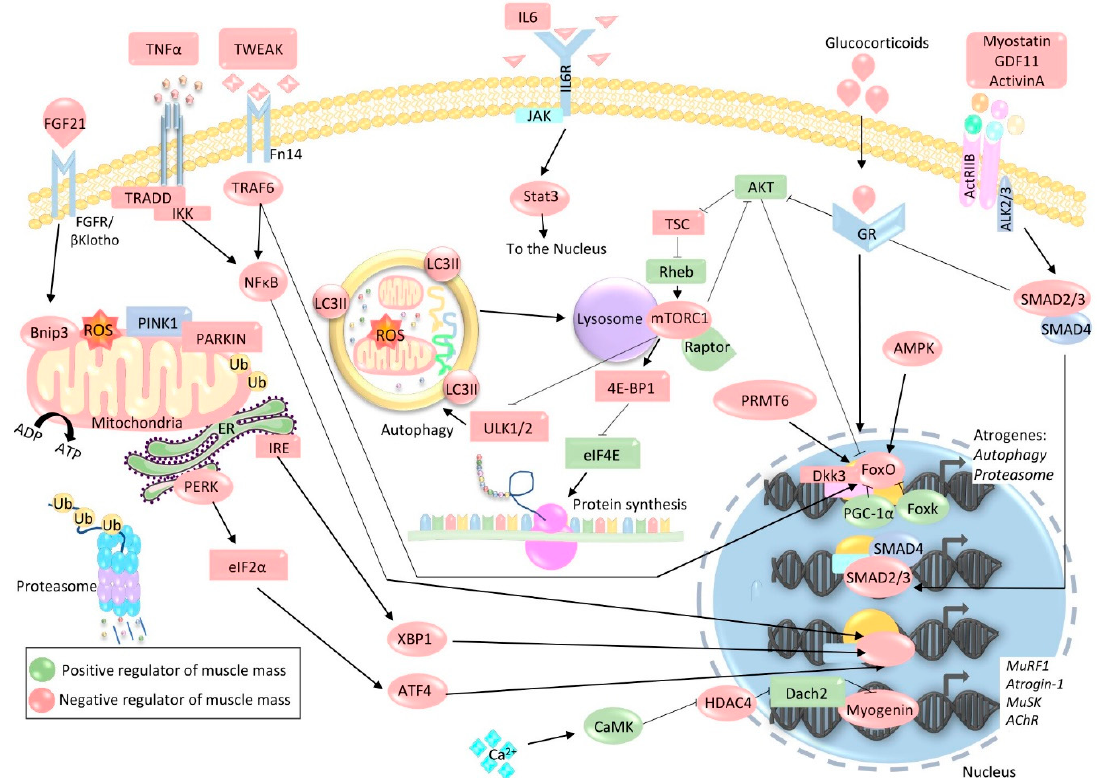
Figure 2. Pathways involved in protein degradation. During muscle atrophy, decreased binding of IGF-1 / insulin to their respective receptors and / or increased binding of glucocorticoids to the glucocorticoid receptor (GR) result in reduced Akt / mTOR activation. This leads to diminished protein synthesis mediated by 4E-BP1-induced inhibition of eIF4E. Diminished mTOR activity also leads to the stimulation of autophagy through ULK1 / 2 signaling. At the same time, reduced Akt activity results in the release of FoxO from its cytosolic captivity, allowing it to activate an atrophic program by stimulating the expression of atrogenes belonging to the autophagy lysosome and ubiquitin proteasome proteolytic pathways. This sustains the increased proteolytic activity of these systems. The FoxO-induced atrophic program can be further enhanced by Dickkopf 3 (Dkk3) and blocked by PGC-1 α and Foxk. Increased binding of activins (ActivinA, growth and di ff erentiation factor 11 (GDF11)) and myostatin to the Activin type 2 (ActRIIB) receptor can contribute to atrophy through the activation of activin receptor-like kinase (ALK)2 / 3 and the formation of the SMAD2 / 3-SMAD4 complex, which in addition to further inhibiting Akt, also induces the expression of proteins involved in atrophy. Muscle atrophy is often accompanied by inflammation, which contributes to proteolysis. Increased levels of circulating cytokines such as tumor necrosis factor α (TNF α ), TNF-like weak inducer of apoptosis (TWEAK), and IL6 leads to the activation of TRAF6, TRADD, IKK, and JAK which, in turn, activate NF- κ B, Stat3, and FoxO, thus enhancing the expression of atrogenes. Mitochondrial dysfunction is also often observed during muscle atrophy, which leads to increased oxidative stress and mitophagy. Oxidative stress stimulates the release of IGF21, which then feeds back onto muscle, enhancing the expression of mitophagy receptor Bnip3. Accumulation of PINK1 and localization of E3 ubiquitin ligase Parkin as well as Bnip3 on the mitochondrial membrane lead to the elimination of dysfunctional mitochondria by mitophagy. Muscle atrophy is also associated with ER stress, which activates the unfolded protein response (UPR). UPR-activated IRE and PERK-eIF2 α then promote atrophic transcriptional programs regulated by X-box binding protein 1 (XBP1) and ATF4, respectively. HDAC4, which is normally supressed by CaMK, is upregulated during denervation, resulting in the inhibition of Dach2, a transcriptional repressor of myogenin. This culminates in increased myogenin-mediated transcription of synaptic factors MuSK and AChR, as well as atrogenes muscle ring finger1 (MuRF1) and Atrogin-1. Green shapes indicate positive regulators of muscle mass, whereas red shapes indicate negative